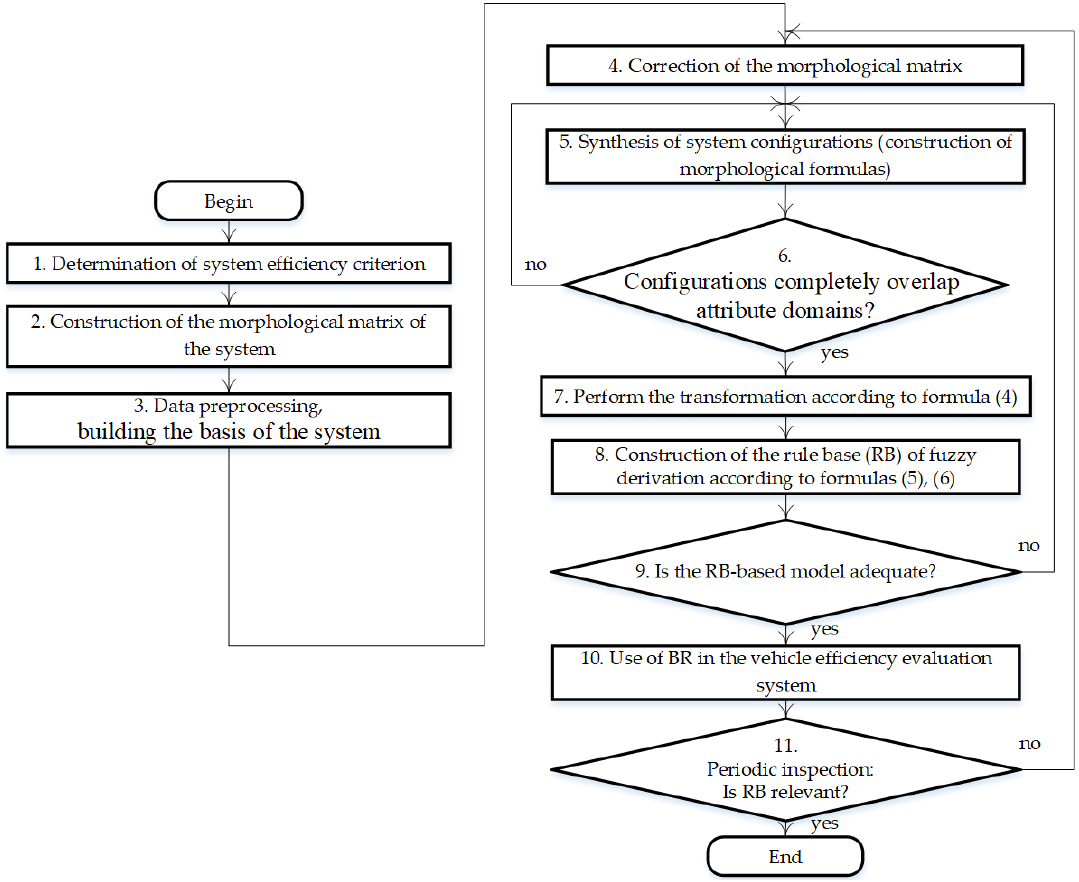
Figure 2. Scheme of the proposed approach.